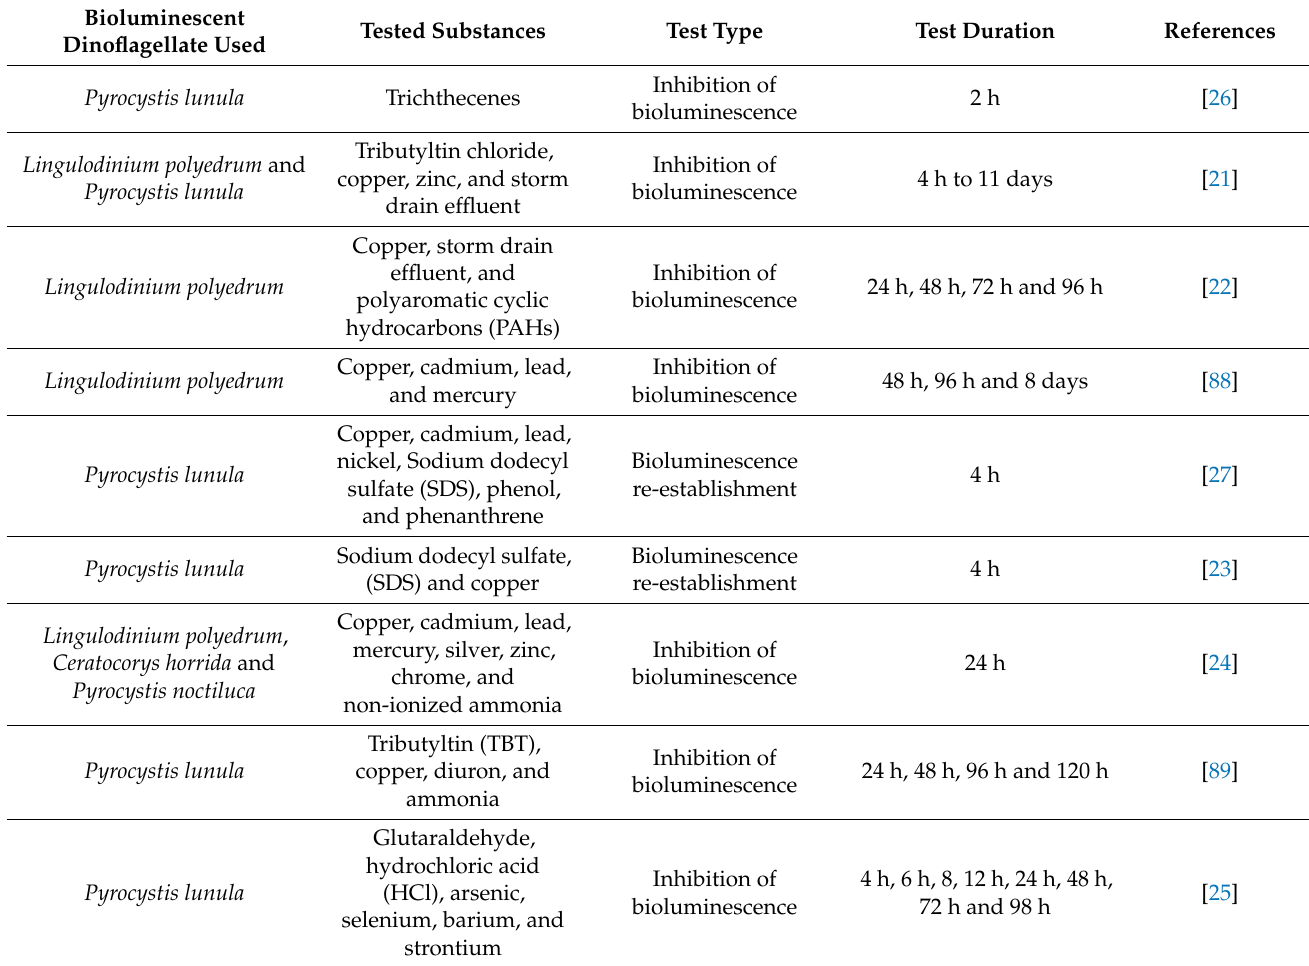
Table 2. Environmental bioassays performed with bioluminescent